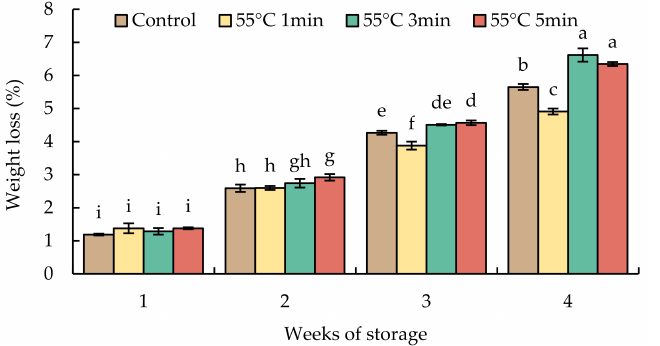
Figure 3. Effect of hot water treatment (55 ◦ C for 1, 3, 5 min) on weight loss in red sweet pepper fruit during storage at 10 ◦ C. Data represent means ± S.E. (n = 3). Different letters on bars are significantly different ( p < 0.05).